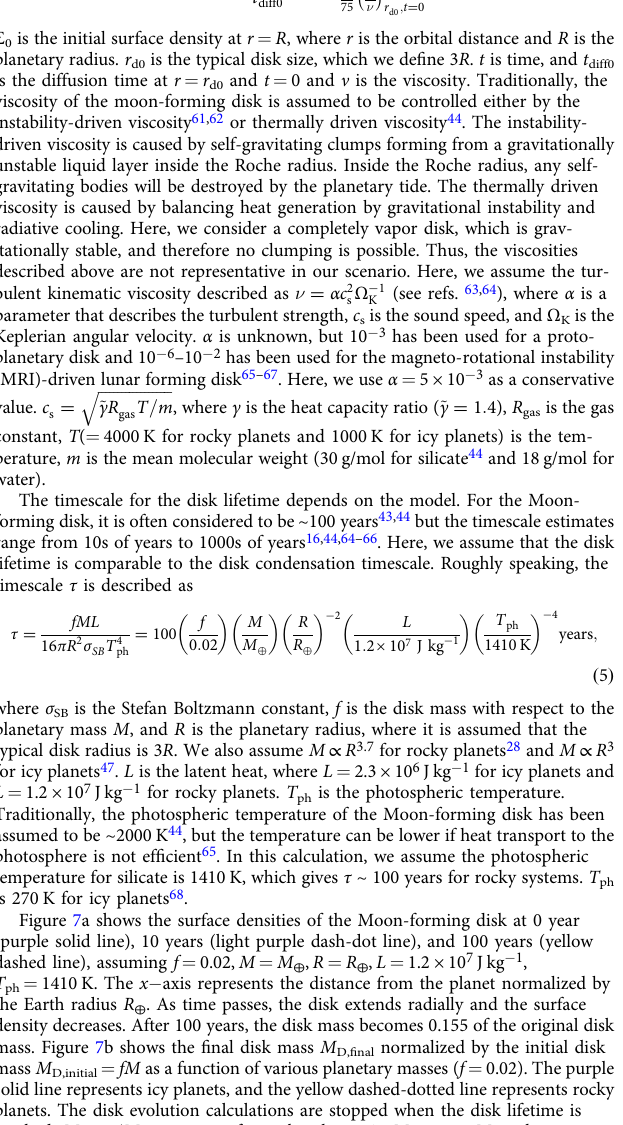
km-sized moonlets.